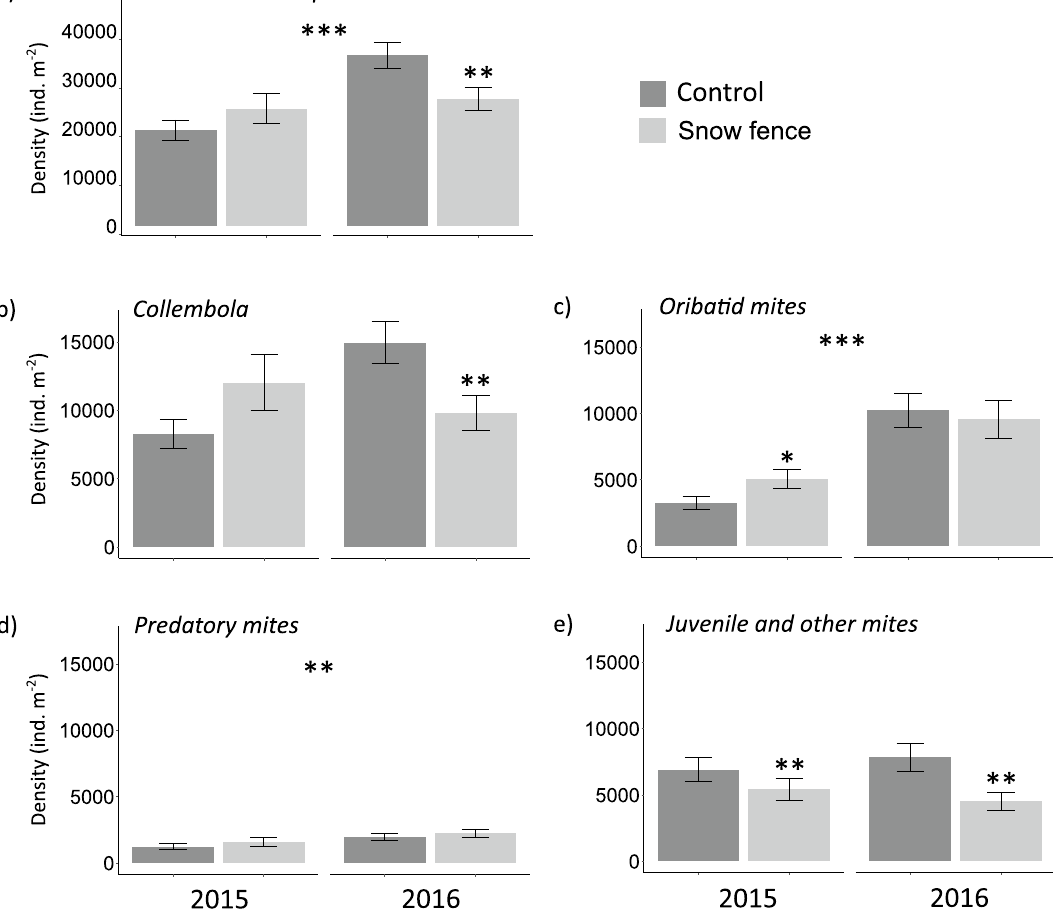
Figure 3. Microarthropod group densities in Arctic tundra (Adventdalen, Svalbard) in experimentally snow accumulated areas behind a snow fence (dark grey) and non-manipulated ambient areas (light grey) sampled in early summer 2015 and 2016. Densities (individuals m −2 ) for ( a ) Total microarthropods, ( b ) Collembola, ( c ) Oribatid mites, ( d ) Predatory mites and ( e ) Juvenile and other mites, are averaged for samples taken from different vegetation types. Asterisks directly above error bars indicate statistically significant difference between treatment effects within the respective years. Asterisks in the middle above all bars indicate significant changes in general microarthropod densities over years (n = 11). *P < 0.05, **P < 0.01, ***P < 0.001, error bars are standard